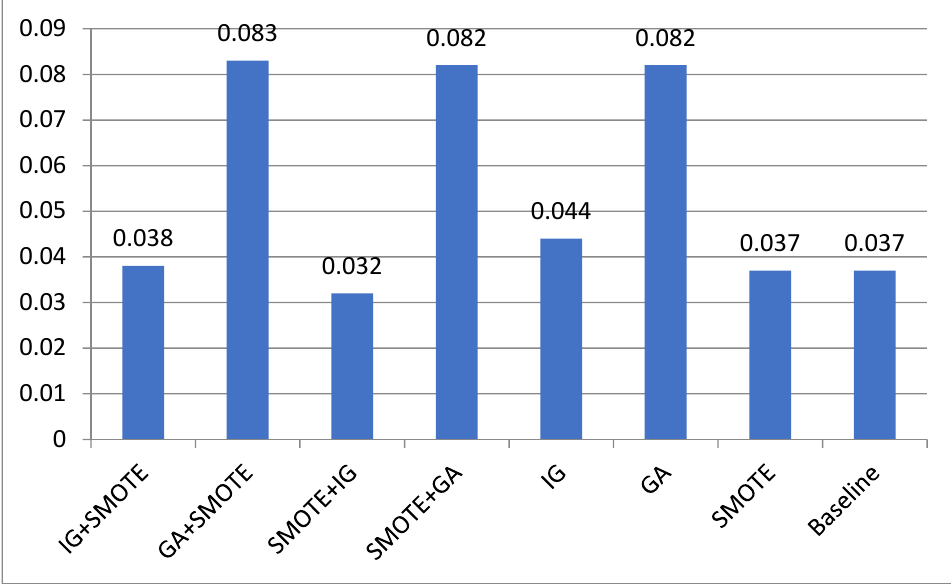
Figure 4. The type I errors of different approaches over the Breast Cancer Wisconsin Dataset.